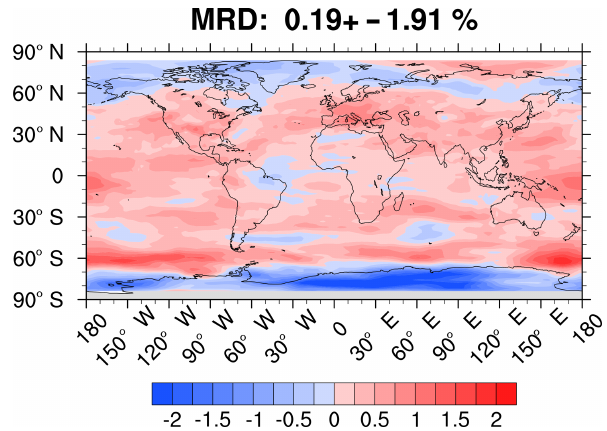
Figure 3. UVI annual mean relative difference between the median UVI obtained from the 18 CCMI model data used and TUV and the UVI obtained from the CCMI median TOZ used with TUV for the period 2000–2010. First, we compute the relative difference: − UVI MEDIAN UVI RD [ % ] = 200 × UVI ALLM . Then we compute the UVI ALLM + UVI MEDIAN average of UVI RD over the period 2000–2010 for each